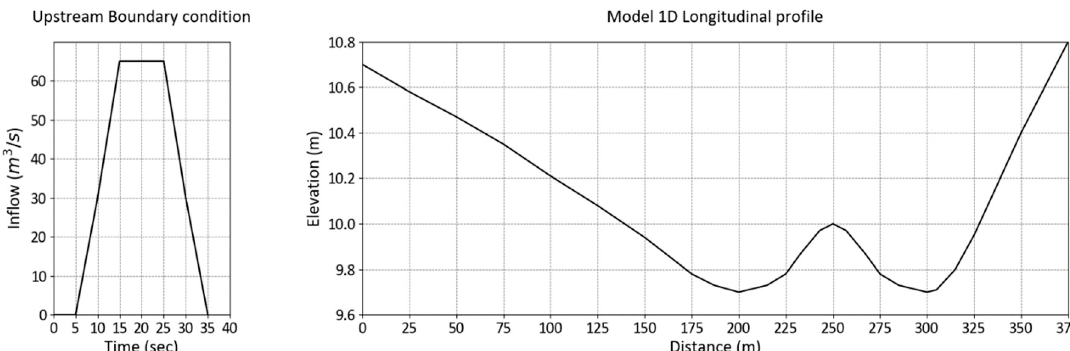
Figure 2. Momentum conservation over a hump case: longitudinal profile and inflow hydrograph at the upstream boundary. Total inflow volume of the inflow hydrograph in Figure 2 is 1310 m 3 . Table 3. Momentum conservation test cases.